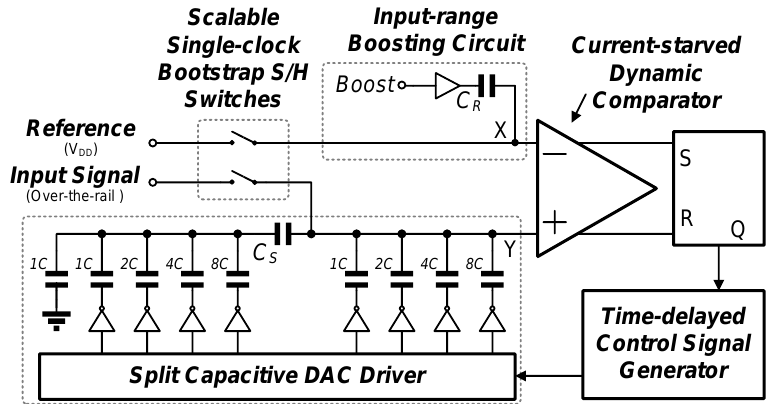
Figure 5. Block diagram of a 0.5 V, low-power 8-bit SAR ADC with input-range boosting, LVS bootstrapping sample/hold and time-delay control.